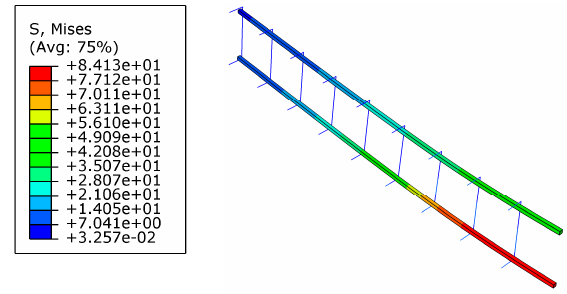
Figure 11. Von Mises stress of steel after pre-cracking (unit: MPa).